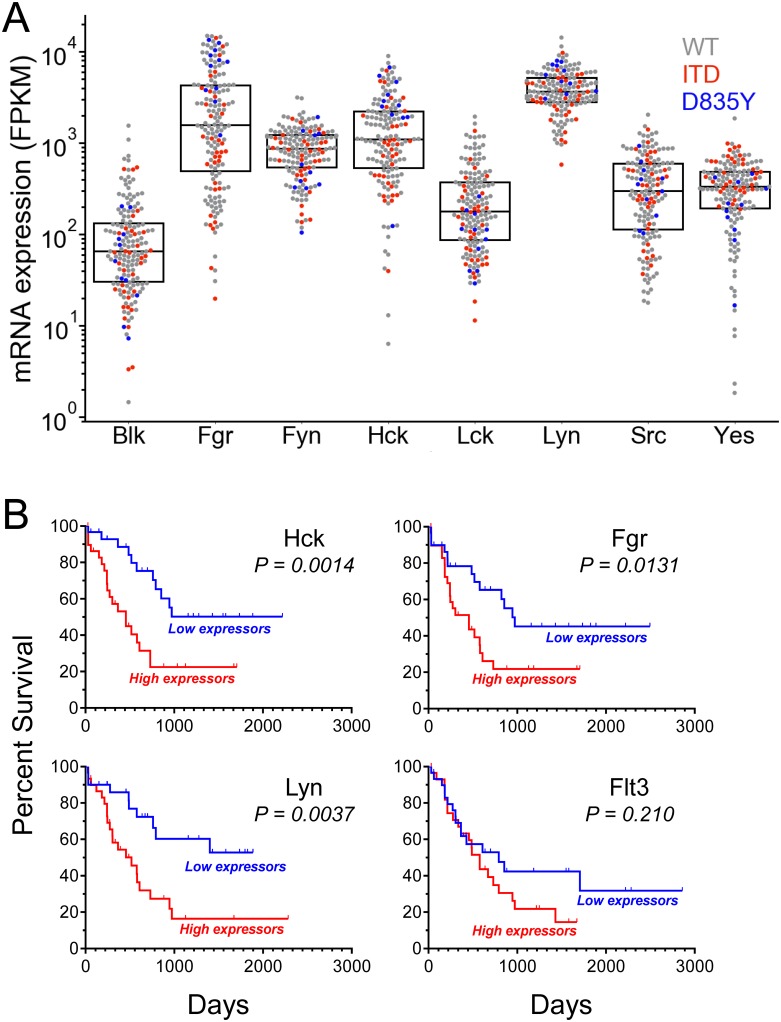
Expression profiles of Src-family kinases in AML and their relationship to patient survival.(A) Gene expression of the eight mammalian Src-family members in samples from all AML patients in The Cancer Genome Atlas (TCGA) cohort (n = 163). Transcript data are shown as the number of kinase cDNA fragments per kilobase of transcript per million mapped reads (FPKM). Dots represent individual patient expression data, with the dot color representing Flt3 mutational status (grey, wild type; red, ITD; blue, D835Y). The boxplot shows the mean and quartile (25–75%) expression values for each kinase. Expression values of each Src-family member were compared to that of the B cell kinase Blk as reference control. One-way ANOVA showed significant differences in Fgr, Hck, Lyn, and Fyn levels relative to Blk (p < 0.0001), while Src, Lck and Yes expression levels were not significantly different. (B) Kaplan-Meier survival analysis for AML patients with the highest (top 20%; red) and lowest (bottom 20%; blue) mRNA levels for FGR, HCK, LYN and FLT3 (30 patients per group from 150 cases where survival data was available). The survival difference between patients with high vs. low expression is significant for the Src-family kinases but not FLT3 (P value shown from Mantel-Cox test).